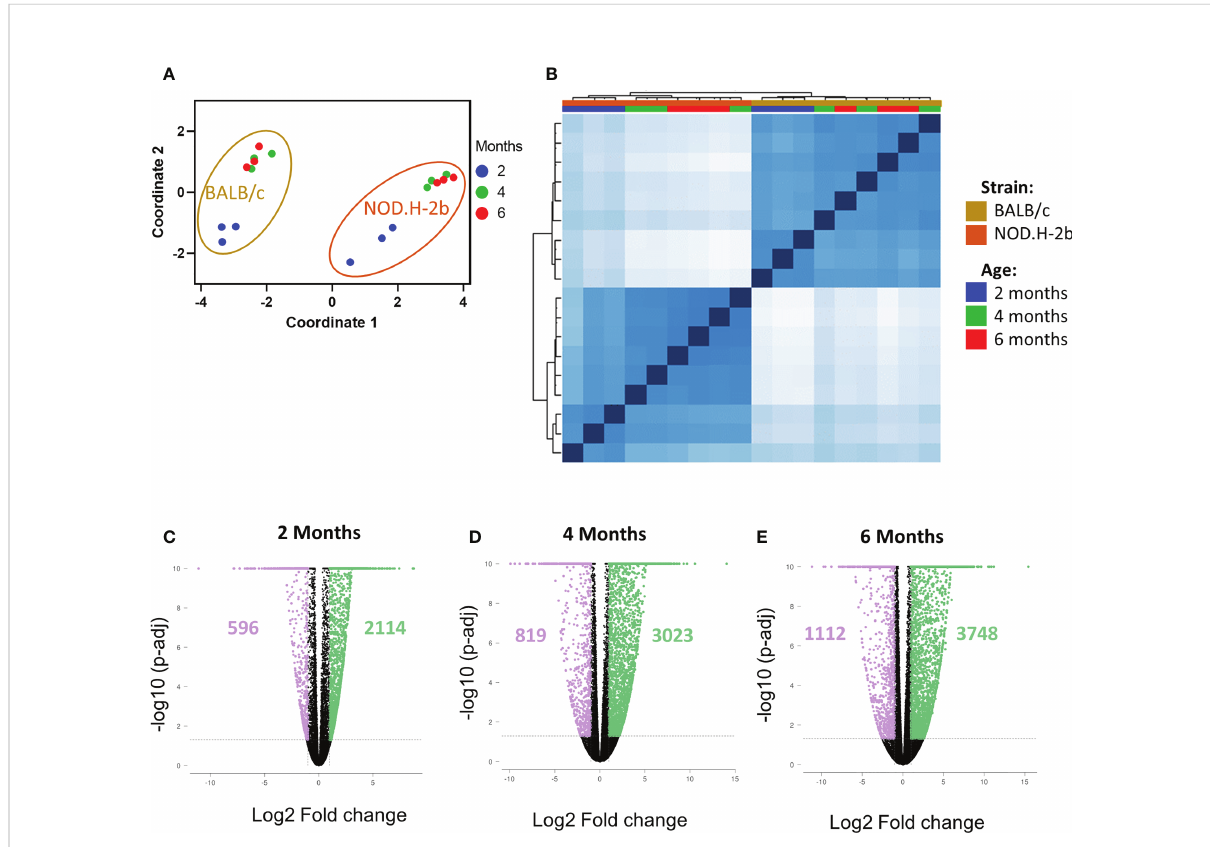
FIGURE 2 QC of RNAseq samples from NOD.H-2b and BALB/c mice and DEGs. Bulk RNA of LG from NOD.B10 and BALB/c have been sequenced (n=3 per group) at 2, 4 and 6 months. Multidimensional scaling (A) and correlation heatmap (B) of the different samples sequenced from NOD (in gold) and BALB/c (in orange) at 2 (blue), 4 (green) and 6 (red) months. The DEGs at each stage for NOD.B10 vs BALB/c were de fi ned with an absolute value of FC > 2 with a p-value adjusted < 0.05. Number of DEGs are represented on the volcano plot at 2 months (C) , 4 months (D) and 6 months (E) . The DEGs downregulated are in purple and the DEGs upregulated are in